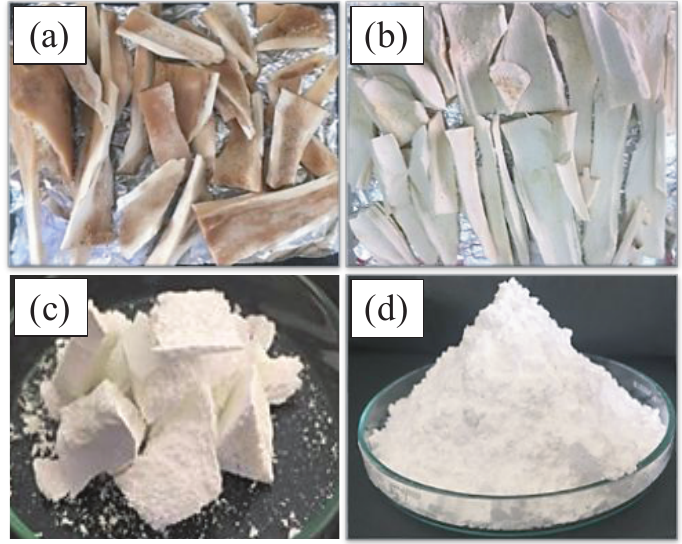
Figure 1: Pictures of bovine bone treated by: (a) hot water at 100°C, 24 h; (b) 0.1 M NaOH solution, 48 h; (c) calcination at 900°C, 6 h; (d) ball milling for 30